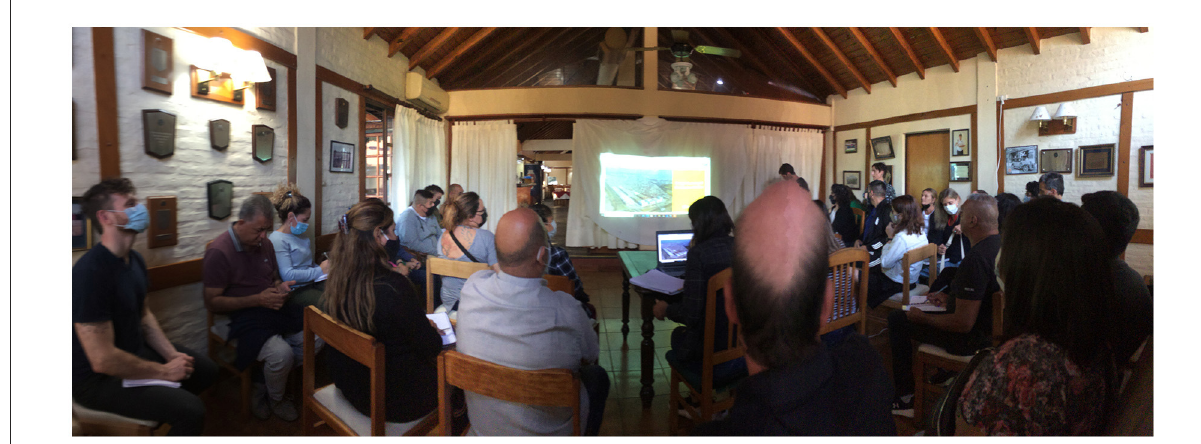
FIGURE3 Urban Lab Buenos Aires – 1st meeting, March, 2022. Source: TUC program.